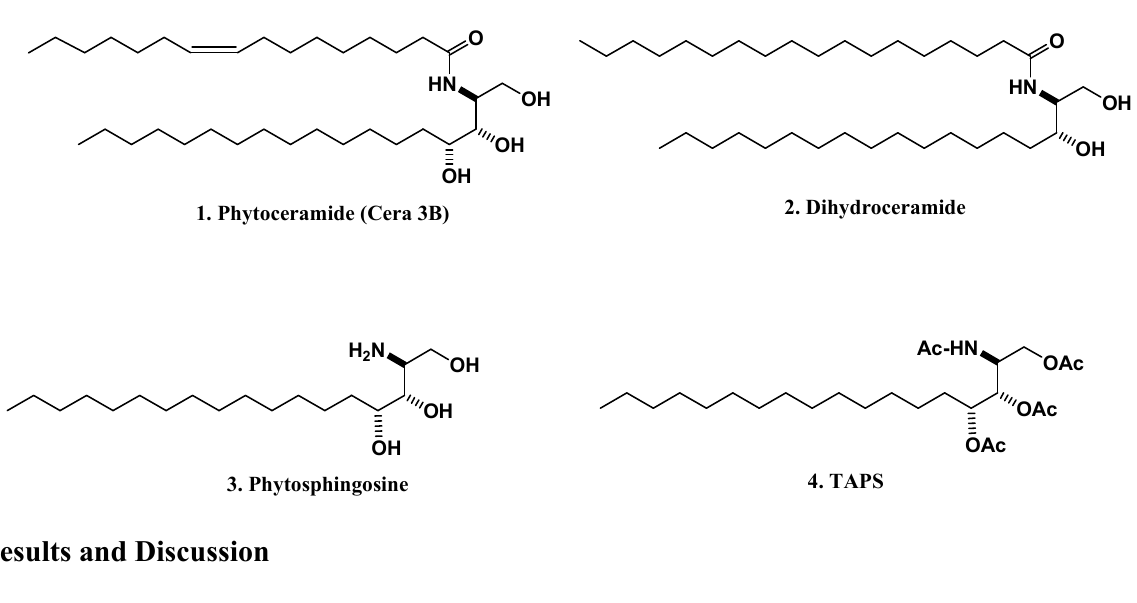
Figure 1. Structures of phytoceramide ( 1 ), dihydroceramide ( 2 ), phytosphingosine ( 3 ), and TAPS ( 4 ).